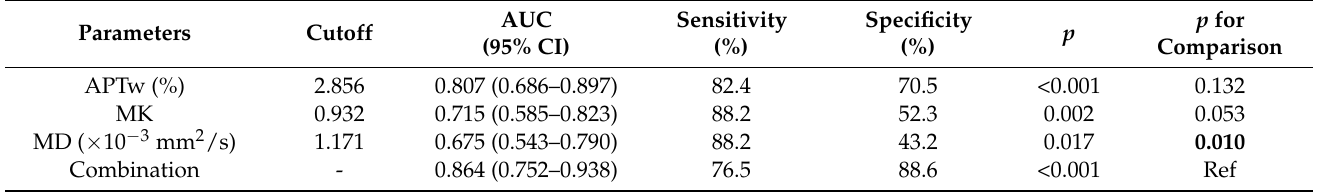
Table 4. Diagnostic performance of APTw, MK, and MD values in predicting LNM in cervical cancer.